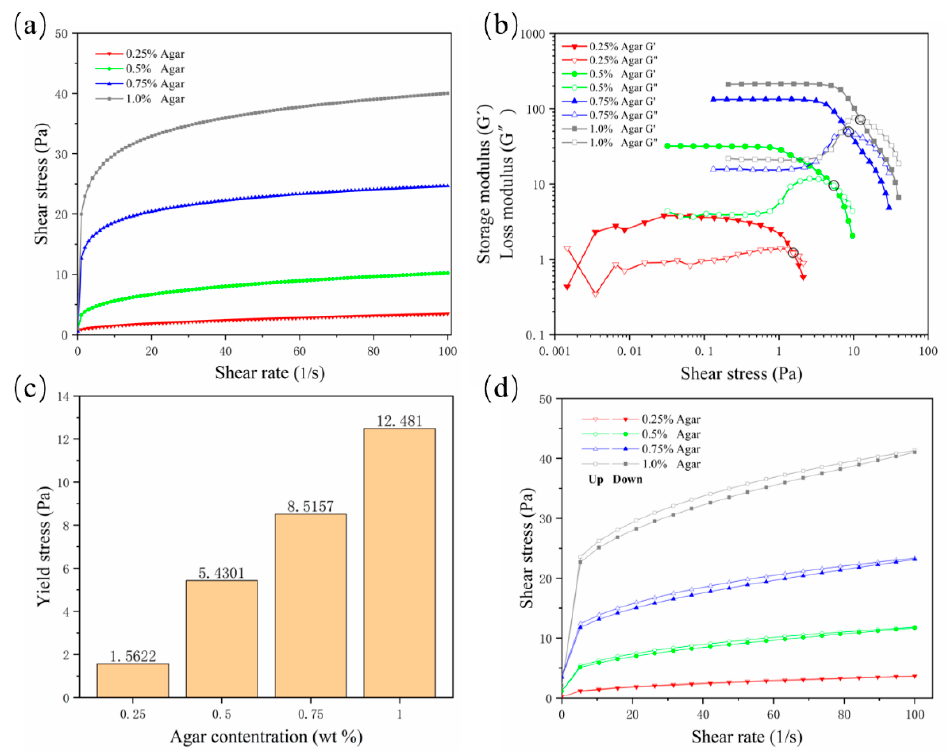
Figure 1. Rheological test results for four concentrations of agarose support bath. ( a ) Rate scan result, which intuitively shows the shear thinning characteristics; ( b ) storage modulus and loss modulus curves; ( c ) yield stress value; ( d ) thixotropy curve.